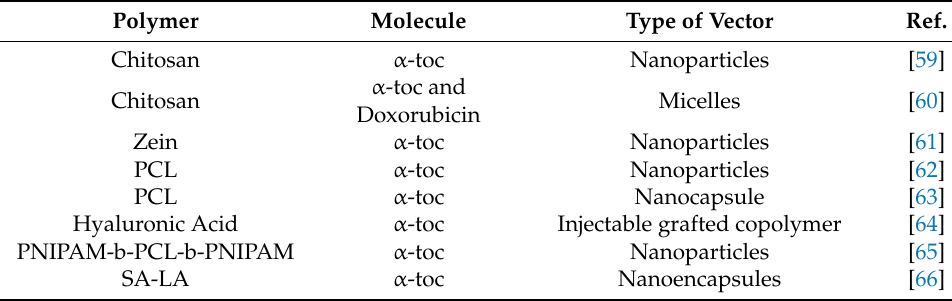
Table 3. Polymeric vectors for Vitamin E